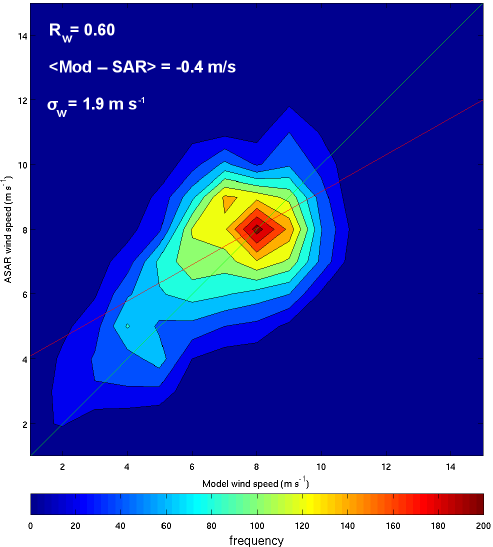
Figure 5. Scatterplot between the CTL run and the ASAR data after resampling at 0.05 ◦ by 0.05 ◦ . Colors indicate the frequency of occurrence in the 1ms − 1 bins. R m is the correlation coe ffi